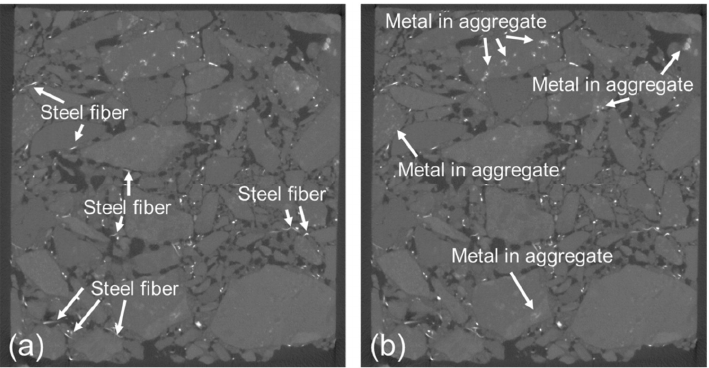
Figure 6. CT scan image of the asphalt mixture: ( a ) Steel fiber; ( b ) Mental contained in aggregate [68].